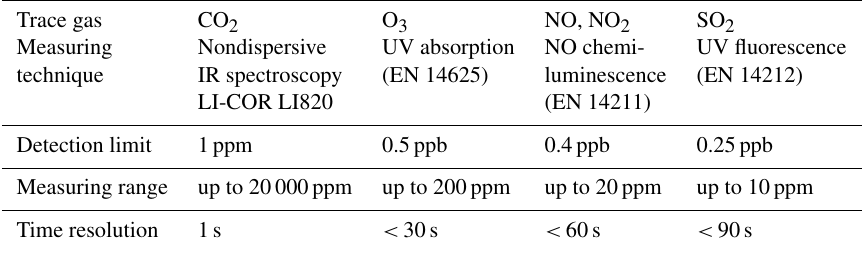
Table 3. Specifications of the Airpointer in situ device: measured trace gases, corresponding measuring techniques, measuring ranges and detection limits (source: MLU-Recordum (manufacturer),